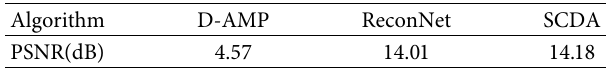
Table 4: Reconstruction accuracy comparison results of D-AMP, ReconNet, and SCDA algorithms (the measurement rate is 0.01).